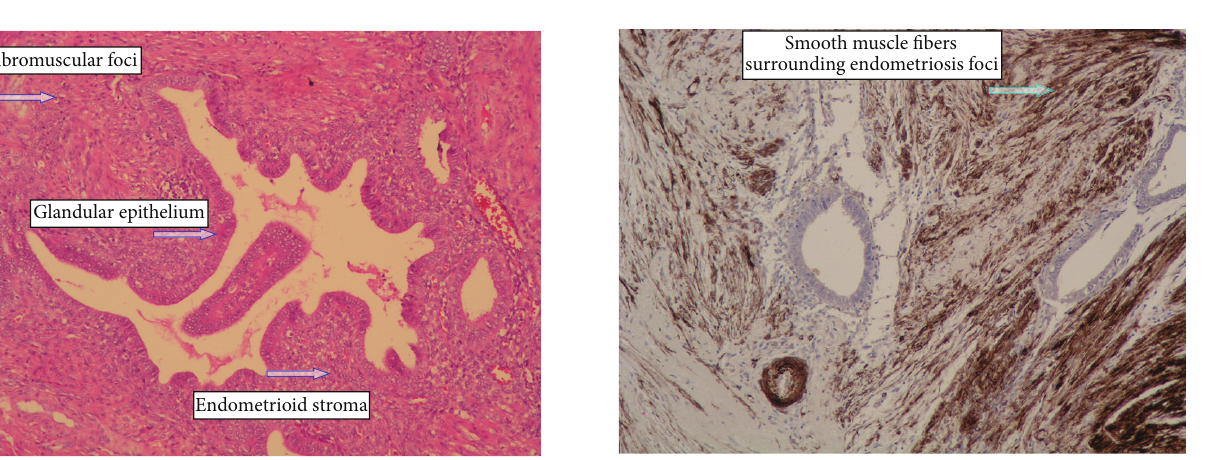
Figure 1: Appendix wall focusing on endometriosis inside. Epithe- lial and stromal components are present. H-E staining. Magnifica- tion 180x.